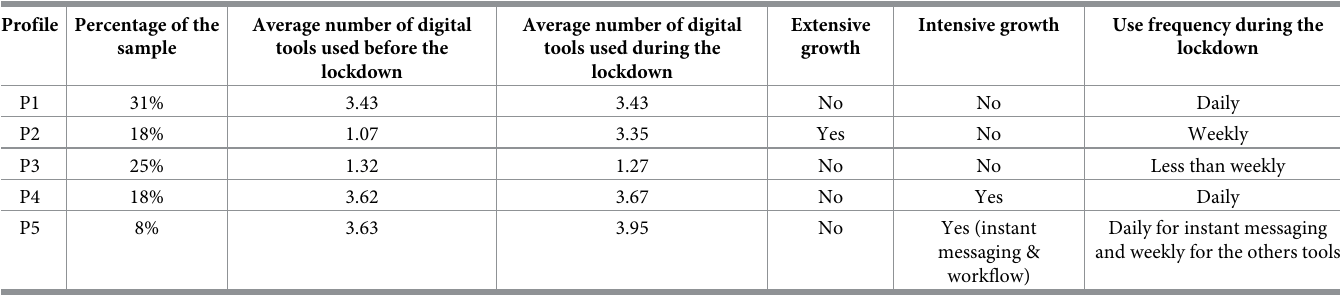
Table 2. Characteristics of the different profiles. Profile Percentage of the Average number of digital sample tools used before